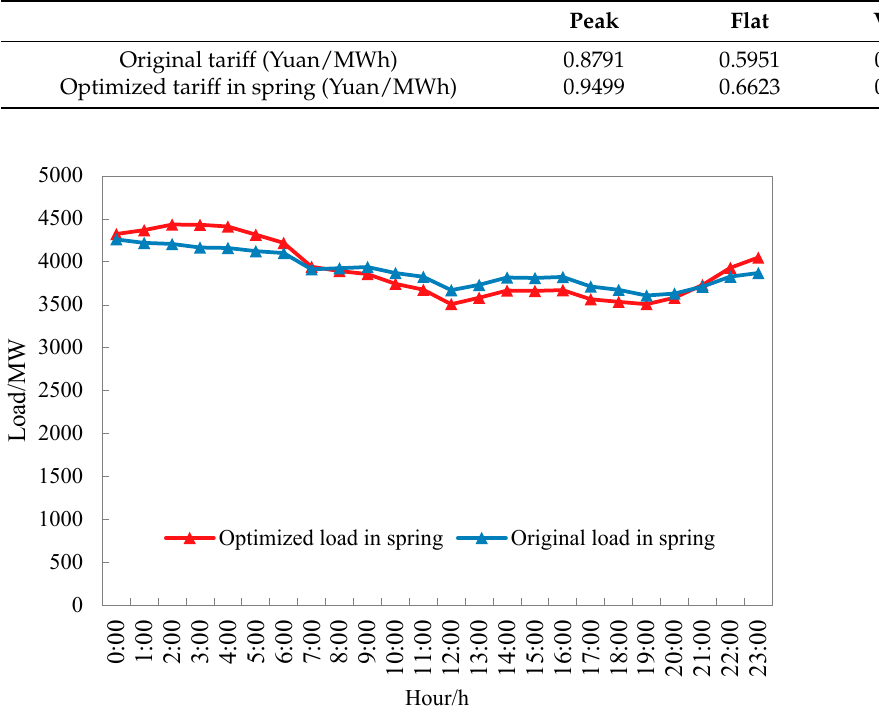
Table 4. The TOU tariff optimization results in spring.